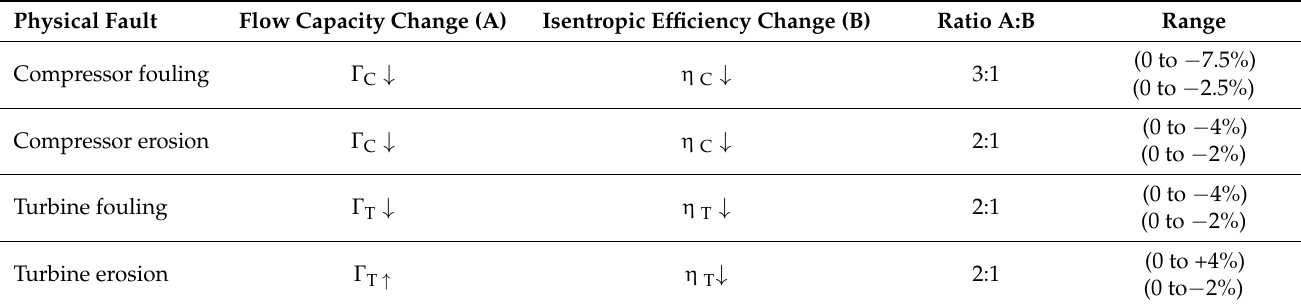
Table 10. Health parameters and the physical fault are related